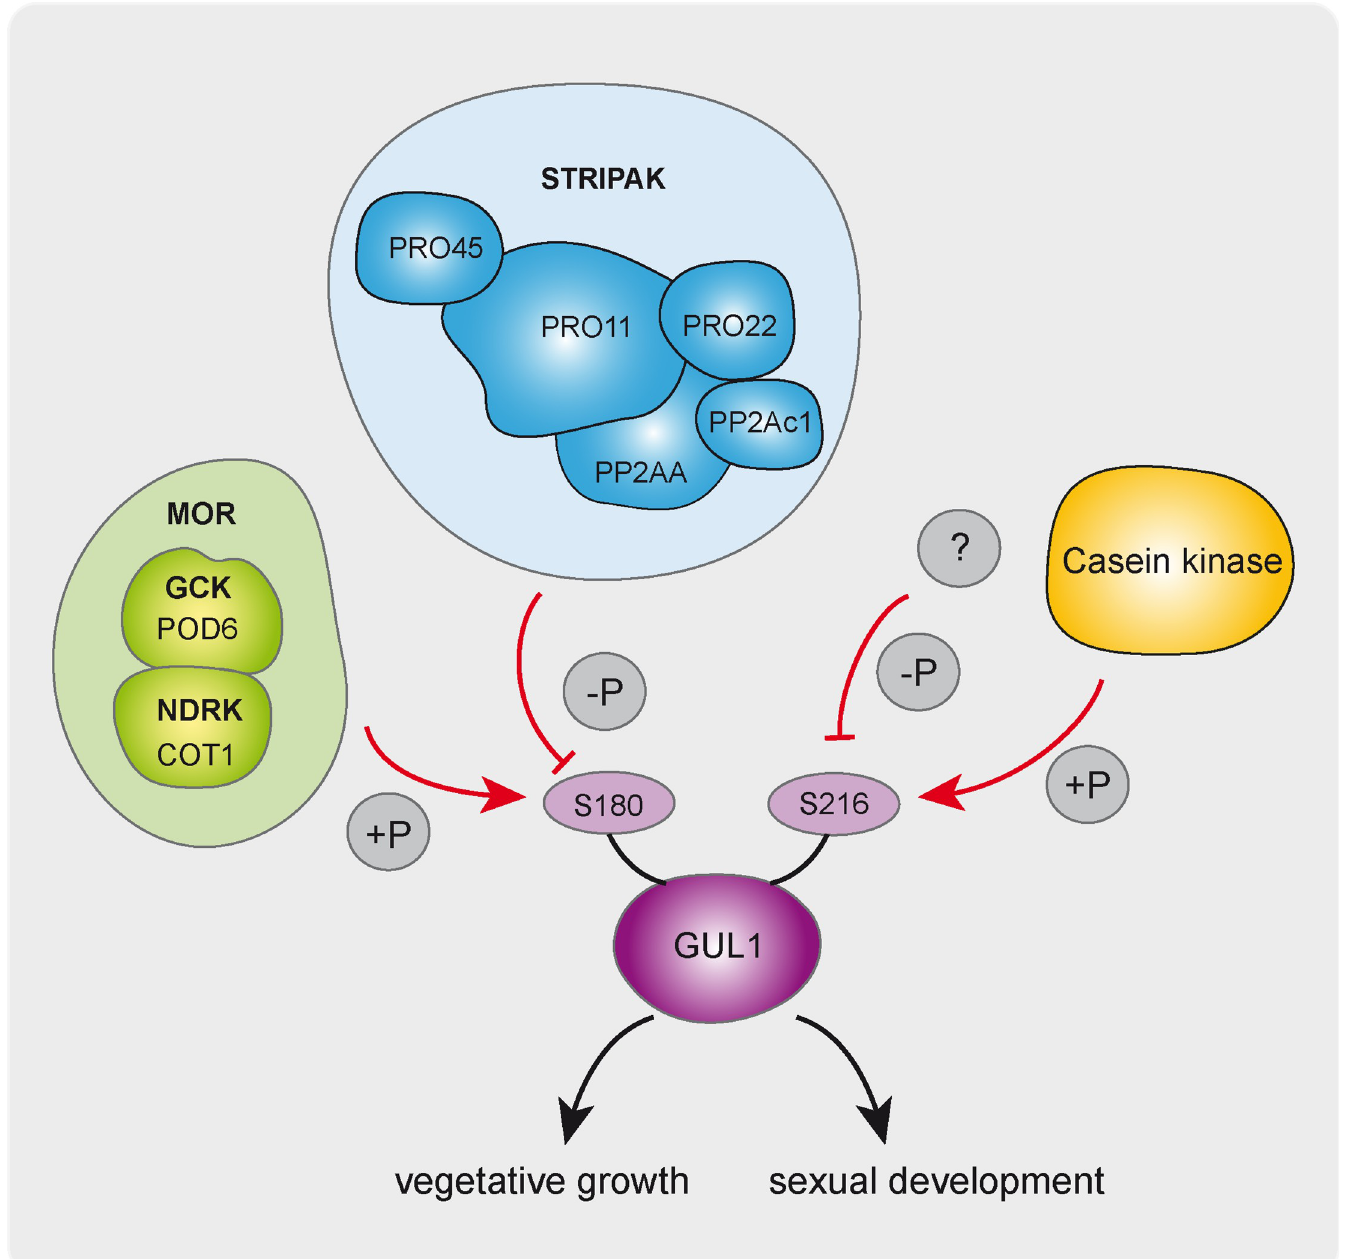
Fig 9. Schematic overview of phosphorylation dependent GUL1 function in sexual and asexual development. S180 is a molecular switch for hyphal growth and morphology, which is targeted by COT1 and STRIPAK. In contrast, S216 is probably targeted by casein kinase and a so far unknown phosphatase. Abbreviations: MOR = morphogenesis orb6 network; STRIPAK: striatin-interacting phosphatase and kinase; GCK = germinal centre kinase; NDRK = nuclear dbf2-related kinase.